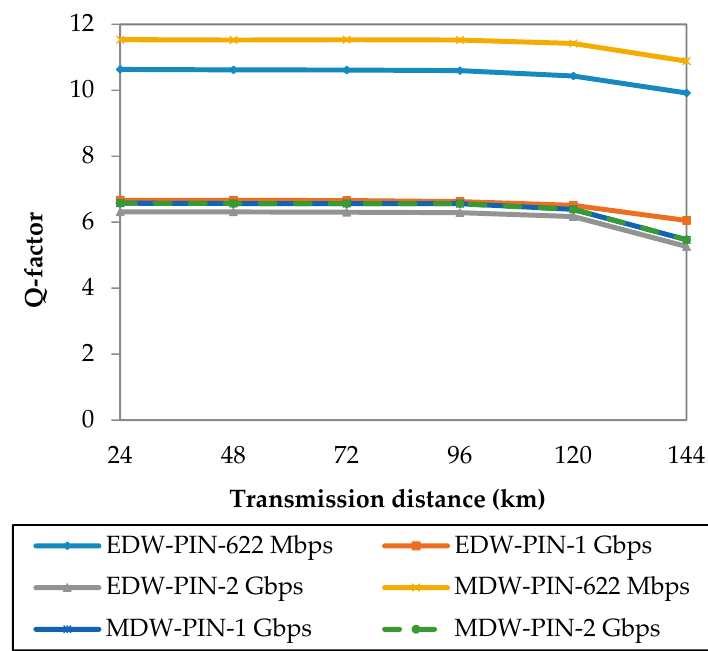
Figure 11. Variation of Q-factor with transmission distance for SAC-OCDMA system using different codes and SPD detection technique at different bit rates in the presence of both DCF and EDFA.